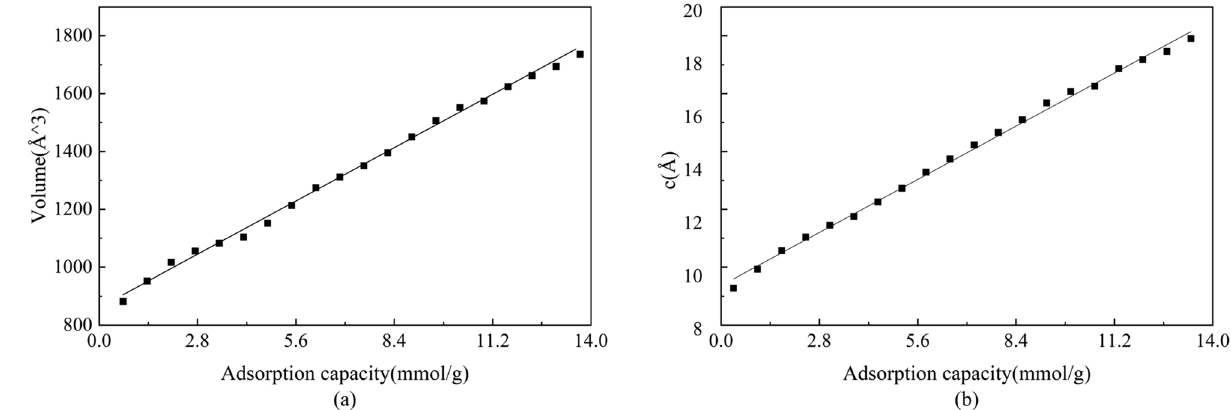
Figure 3. ( a , b ) Respectively represent the unit cell volume and (001) of montmorillonite after